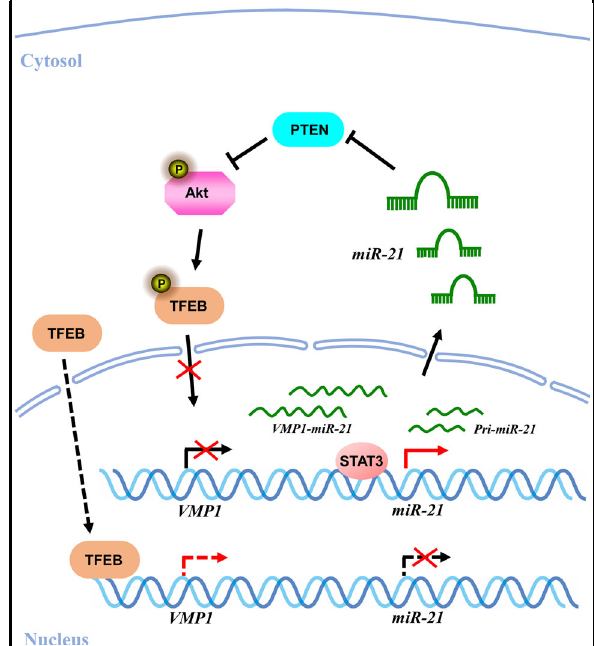
Fig. 7 Proposed model for VMP1 medicated the new feedback regulation mechanism of miR-21 via PTEN/AKT/TFEB pathway in colorectal cancer. When TFEB was activated and transported into the nuclear in cells, VMP1 transcript was upregulated and VMP1-miR-21 transcript was down-regulated, Meanwhile, pri-miR-21 transcript was also reduced due to the binding of transcription factors to pri-miR-21 promoter were blocked by TFEB-induced high transcriptional activation of VMP1, such as STAT3 (dashed lines). When VMP1 transcription was inhibited by TFEB phosphorylation, both VMP1-miR- 21 and pri-miR-21 transcripts were increased. Subsequently, the high expression of miR-21 increased phosphorylation of AKT by inhibiting PTEN, and then phosphorylated AKT promoted phosphorylation of TFEB and repressed its nuclear translocation, leading to VMP1 transcription was further inhibited and miR-21 transcription was further increased (solid